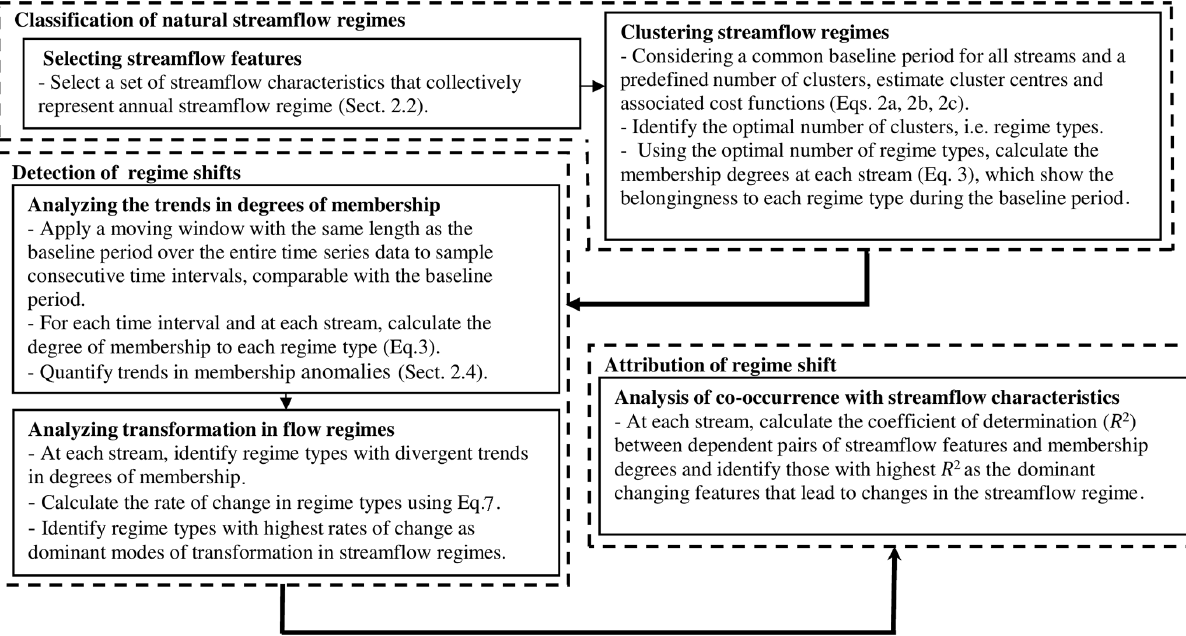
Figure 1. The workflow of the proposed three-step algorithm for classifying streamflow regime, diagnosing shift in streamflow regime, and attributing the regime shift to the changes in streamflow